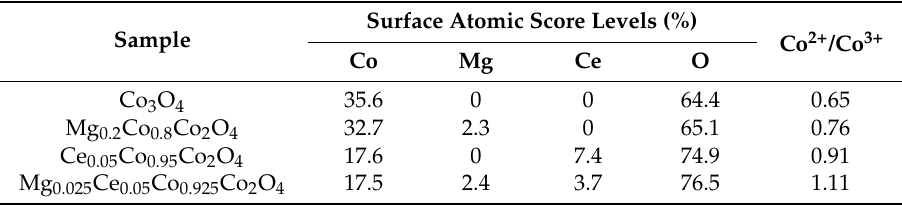
Table 2. XPS surface atomic percentage.